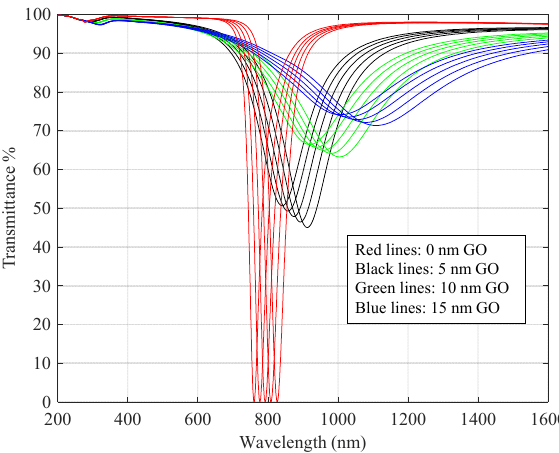
Figure 6. Theoretical spectral transmittance of a GO-deposited DLUWT as the refractive index external medium changes from 1.33 to 1.35, for different graphene oxide layer thicknesses.